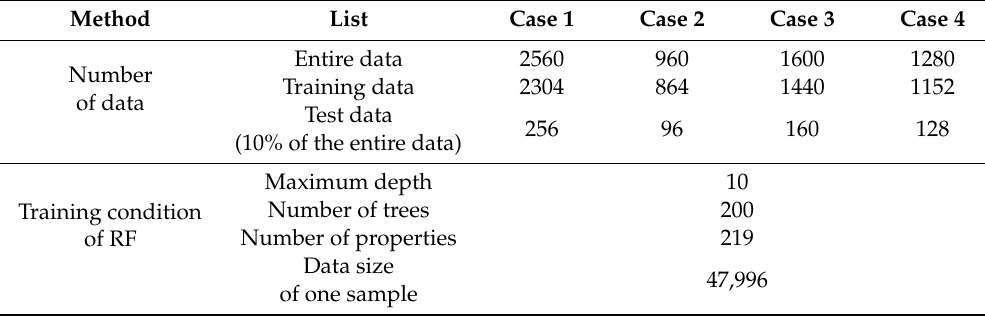
Table 3. Conditions and settings for Cases 1–4 with random forest.